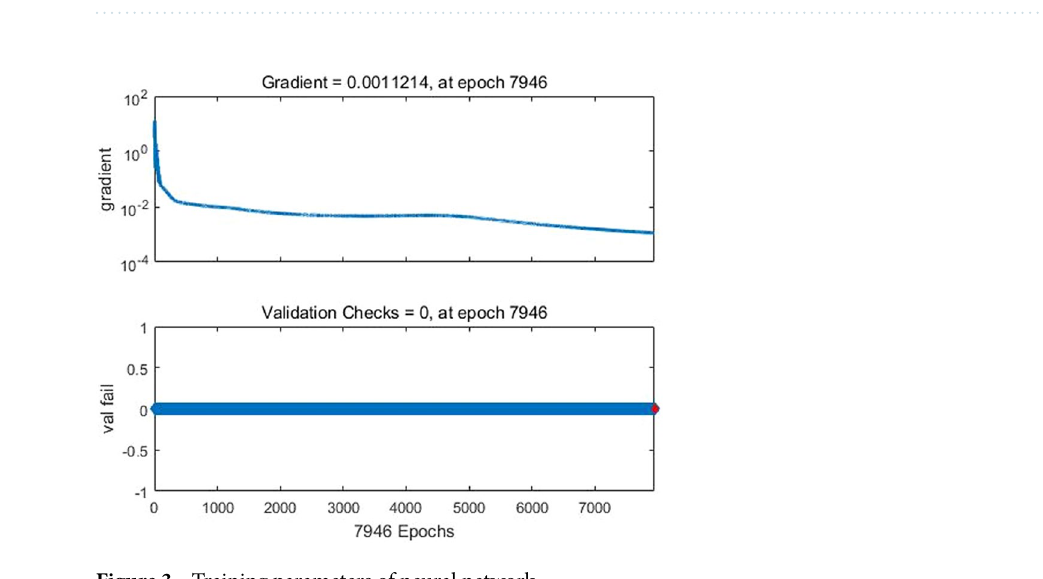
Figure 3. Training parameters of neural network.